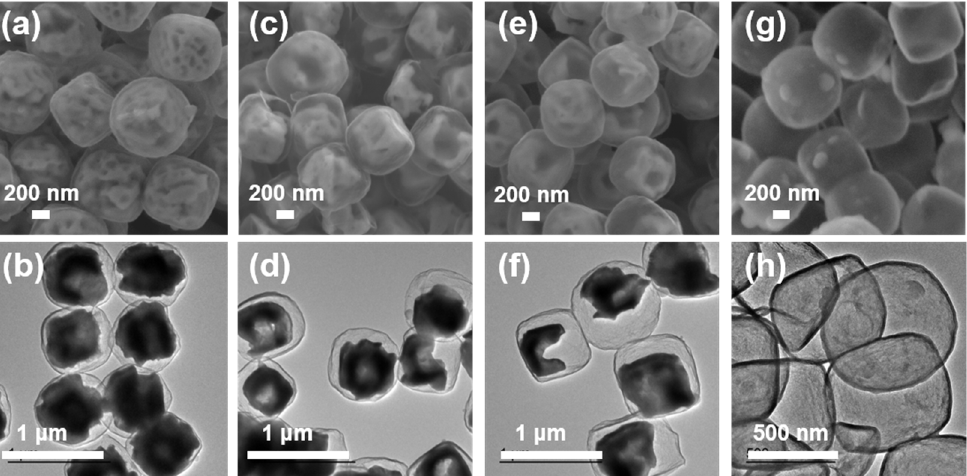
Figure 2. SEM and TEM images of carbonized products after etching for different times: ( a , b ) Fe 3 O 4 @void@N-doped C-2; ( c , d ) Fe 3 O 4 @void@N-doped C-5; ( e , f ) Fe 3 O 4 @void@N-doped C-10; ( g , h ) the product of 4 mol L − 1 hydrochloric acid etching for 2 h.